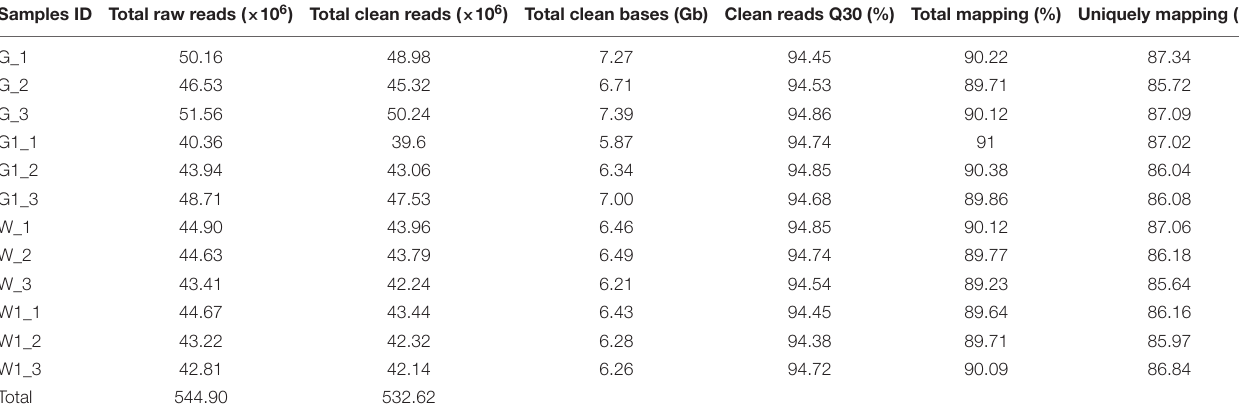
TABLE 1 | Summary of sequencing and assembly statistics for the 12 transcriptome data from different ornamental kale